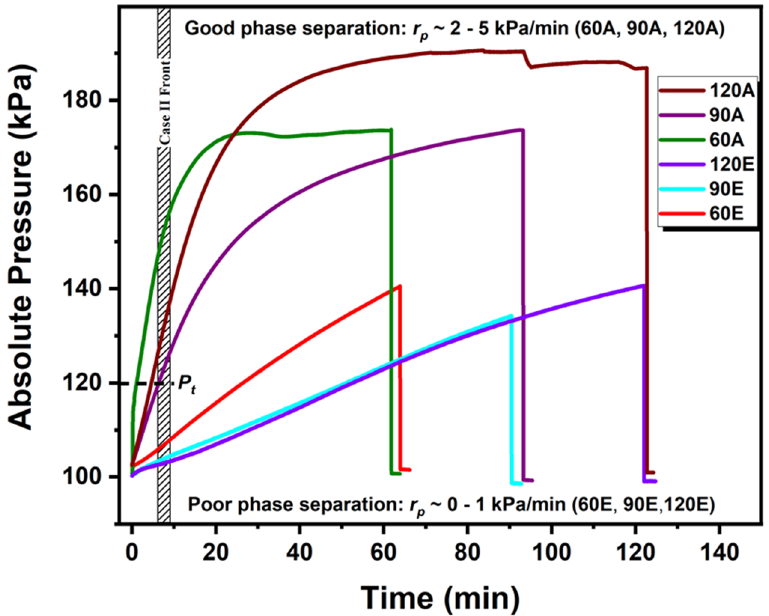
Figure 7. Pressure ramp regimes. Absolute vapour pressure profiles demonstrating the ramp regimes. Reaching threshold pressure (120 kPa) at early stage leads to phase separation with long- range order with higher vapour pressure ramp ( r P > 2 kPa/min ) and poor phase separation with lower pressure ramp ( r P > 1 kPa/min )